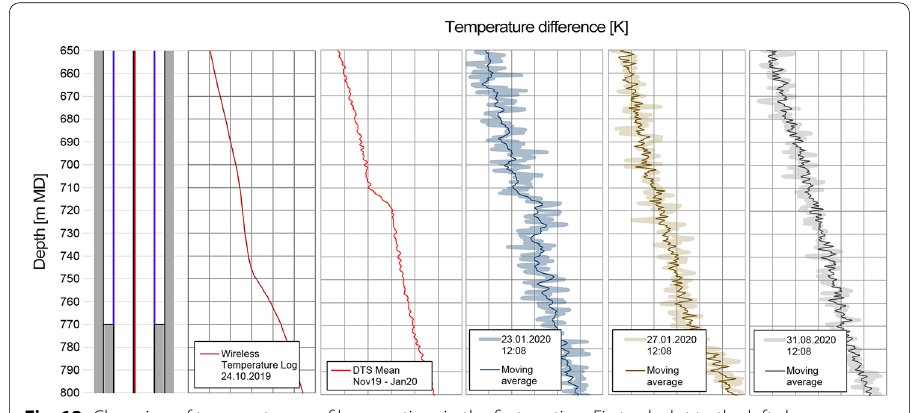
Fig. 12 Changing of temperature profiles over time in the first section. First subplot to the left shows the completion with tieback liner in blue and TEF/sucker rod in red. Second subplot shows the wireline temperature log that was recorded inside the tieback liner. Third to sixth subplots show DTS profiles that were recorded in the borehole as the tieback liner was pulled. Third subplot is the mean DTS profile until start of Inj1, fourth shows a DTS profile shortly before start of Inj1, fifth is 3 days after Inj1, sixth subplot shows a current DTS profile. Transparent lines are raw DTS data, sharp lines are moving average over 4 h at a